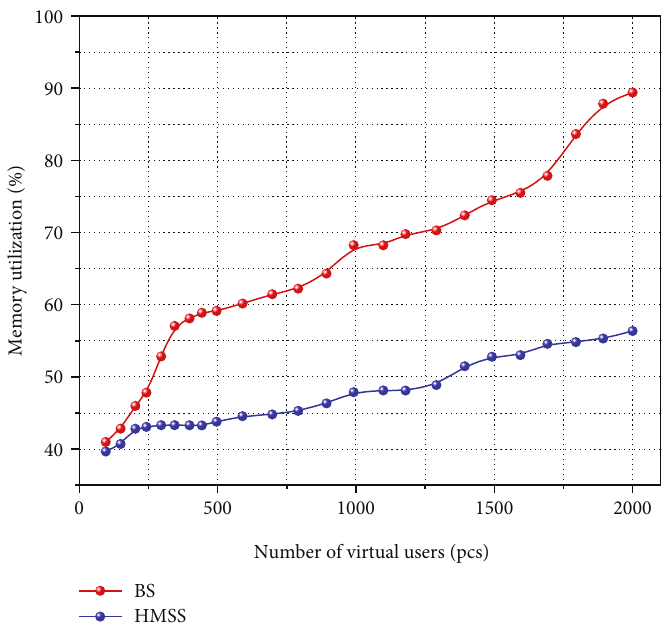
Figure 4: Comparison of memory utilization between HMSS and benchmark authentication